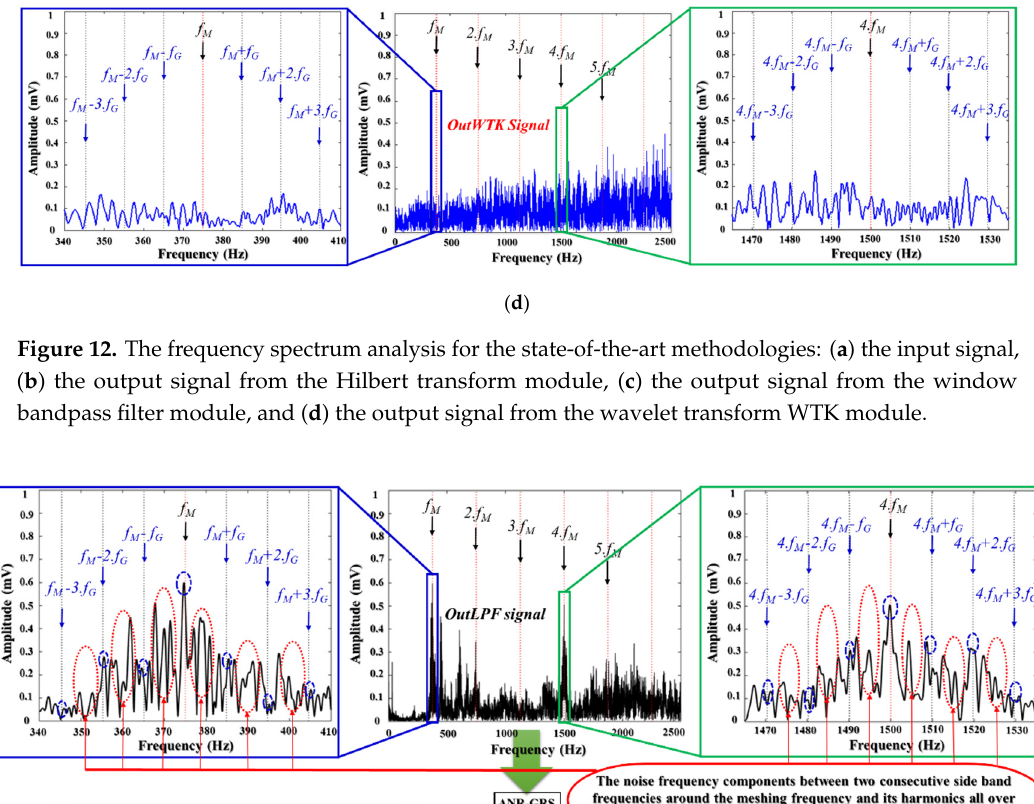
Figure 13. Frequency spectrum analysis of the input and output signal of the ANR-GRS module.